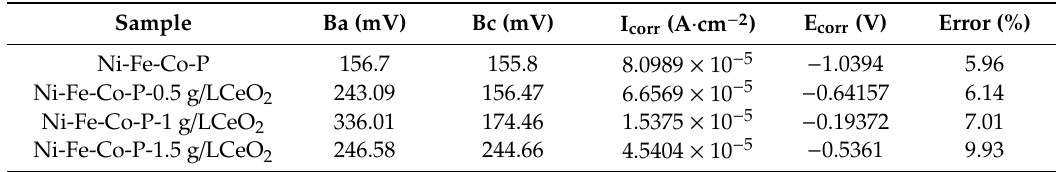
Figure 8. Polarization curves of coatings with different concentrations of nanometer CeO 2 particles. Table 4. Composition of plating solution.